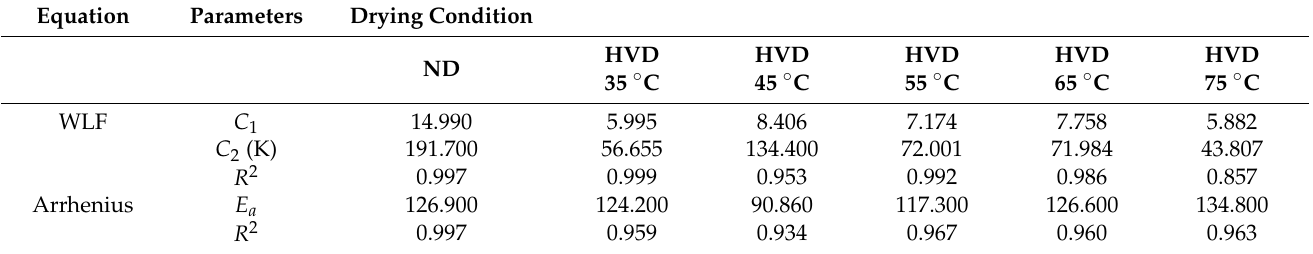
Table 3. WLF constants and Arrhenius activation energy for maize kernels (stress relaxation).